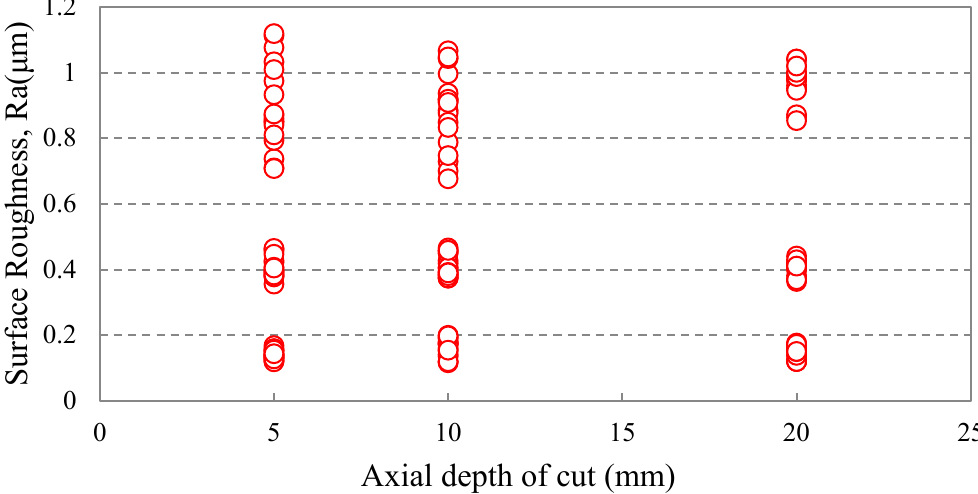
Figure 12. Roughness distribution graph in terms of radial depth of cut.